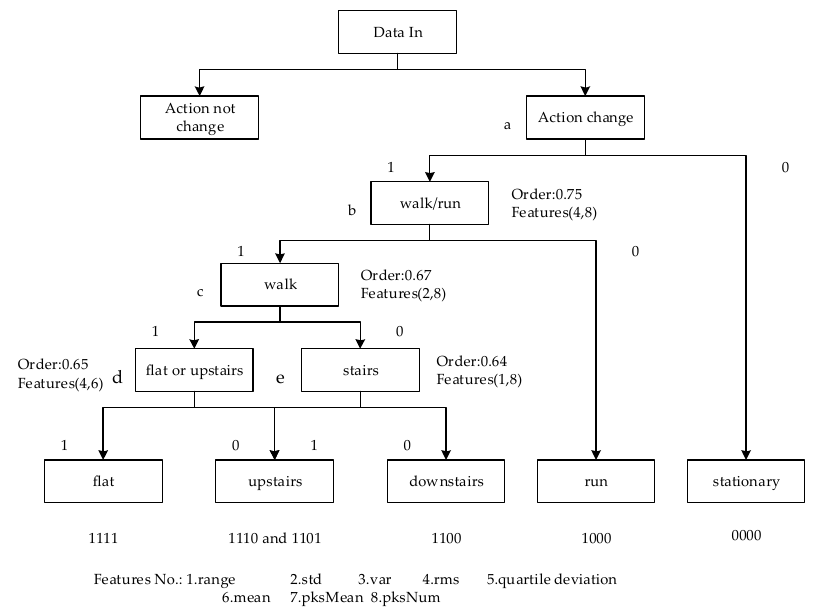
Figure 14. The structure and process of the classifier. As different orders and feature vectors are needed to classify walk, upstairs and dwstairs, one can distinguish walk and dwstairs first, and then separate upstairs from walk and dwstairs, respectively, then separate upstairs from walk and dwstairs, respectively.